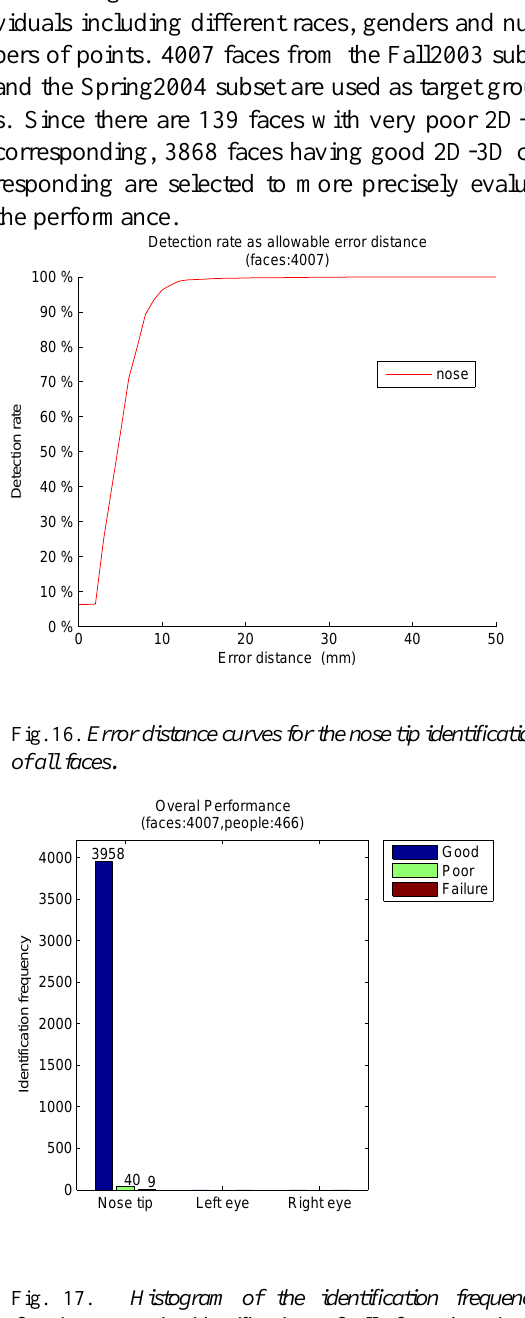
Fig. 17. Histogram of the identification frequency for the nose tip identification of all faces.(Good: 0 − 12 mm;poor: 12 − 24 mm;failure: > 24